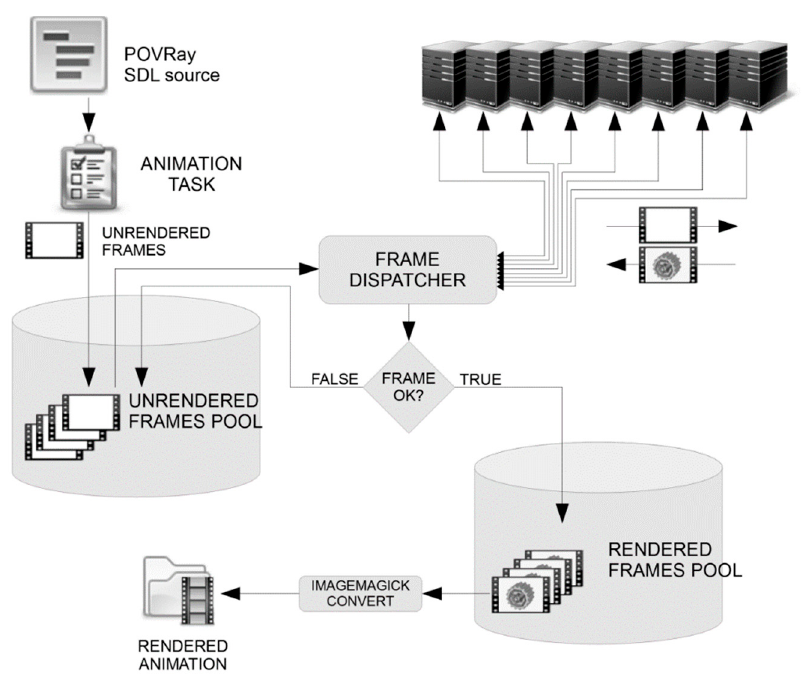
Figure 3. Communication protocol.